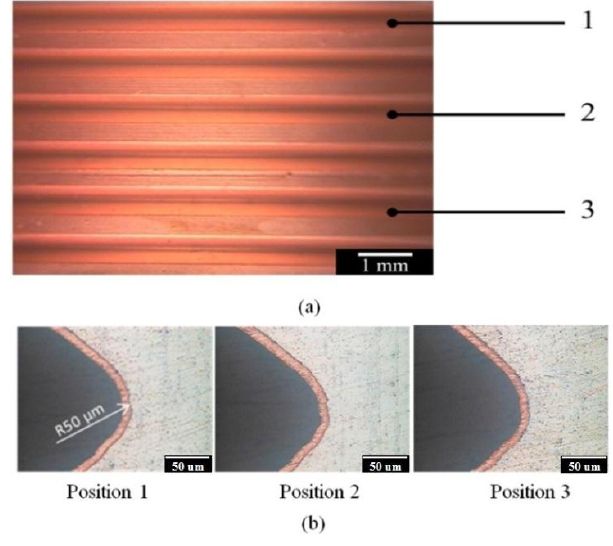
Figure 9. Optical micrographs of ( a ) overview and ( b ) cross section of the Cu-deposited AZ80 specimen with a multi-V